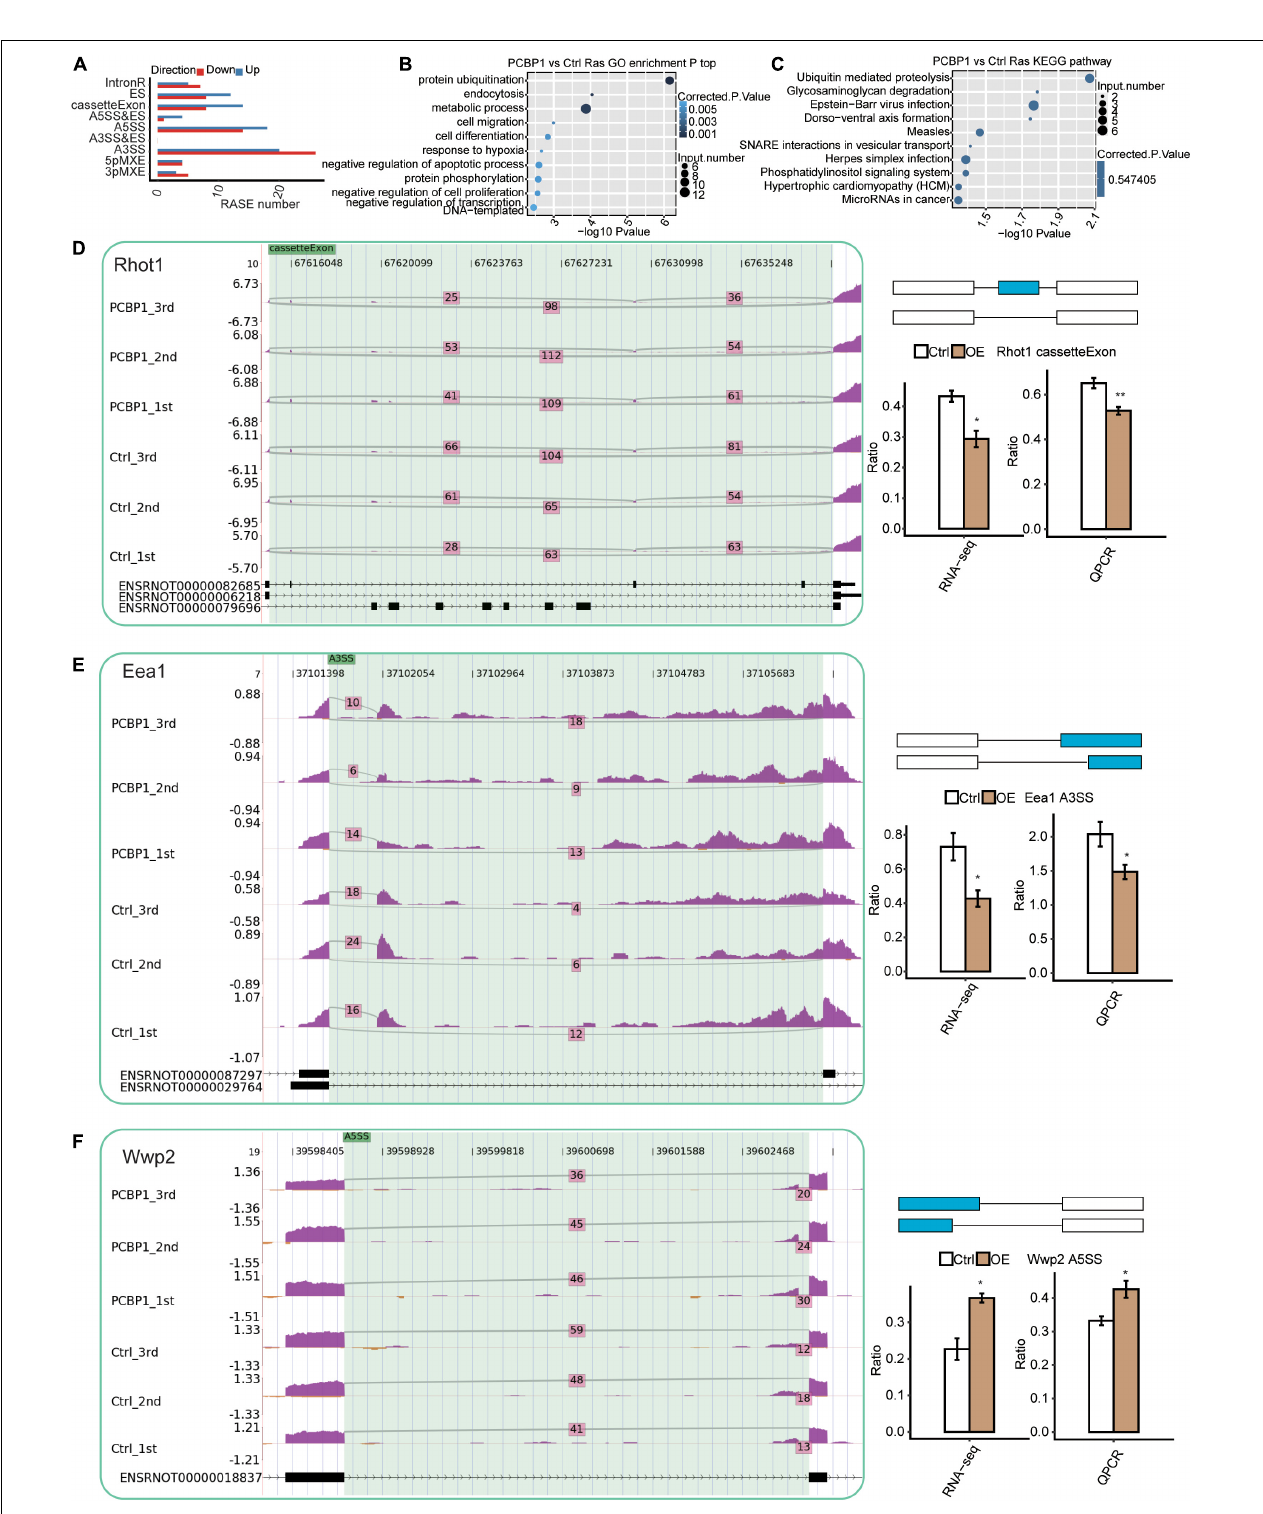
FIGURE 3 | Identification and functional analysis of PCBP-1-mediated AS events. (A) Classification of different PCBP-1 regulated AS events. (B) The top 10 GO biological process analyses and (C) KEGG functional pathway of the alternatively spliced genes. PCBP-1 regulated AS of genes involved in ubiquitination and endocytosis, including (D) Rab1a, (E) Rhot1, and (F) Eea1. Left panel: The schematic diagrams depicting the structures of ASEs, AS1 (purple line), and AS2 (green line). Right panel: The constitutive exons are denoted by black boxes, intron sequences by a horizontal line (top), while alternative exons by a red box. The bottom right panel represents RNA-seq and RT-qPCR validation of AS events. Error bars represent mean ± SEM. ** P < 0.01, * P < 0.05.